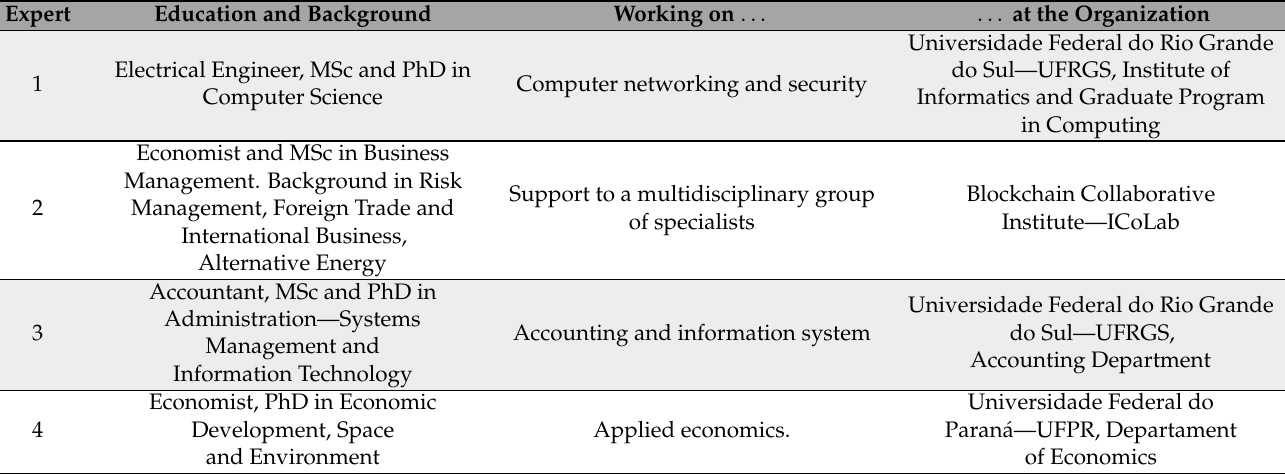
Table 1. Profile of the professionals interviewed in the first phase of the